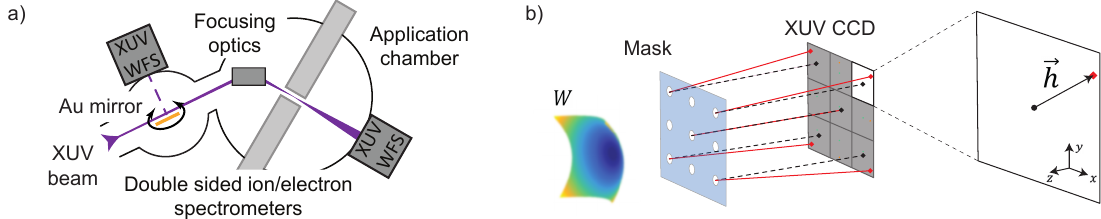
Figure 2. ( a ) Positions of the sensor in the beamline; and ( b ) principle of the Hartmann wavefront sensor. WFS: Wavefront